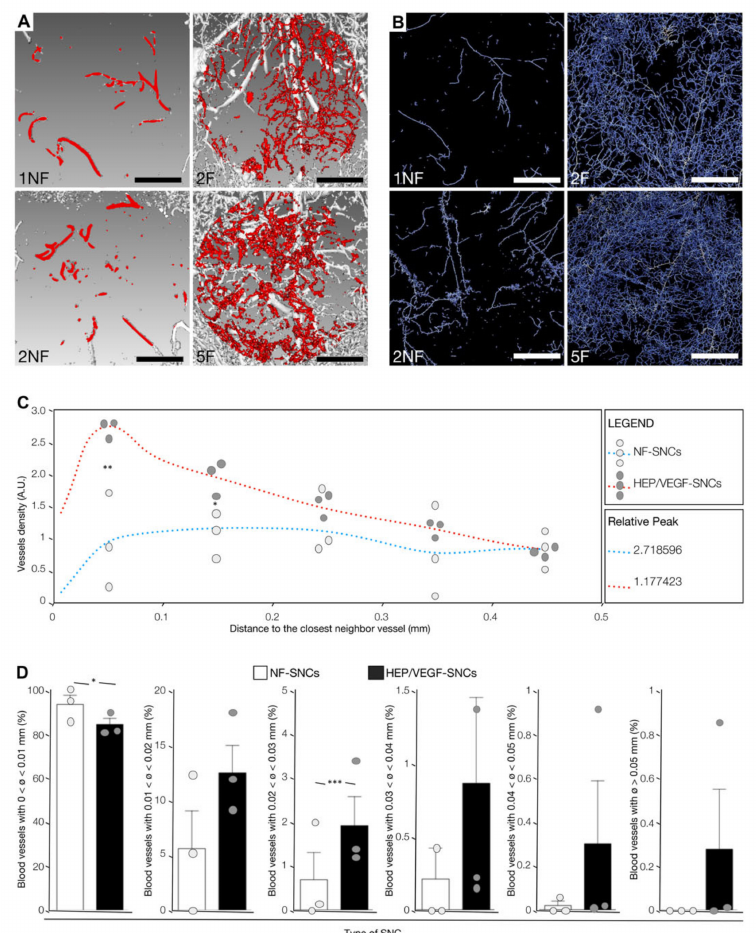
Figure 5. Quantitative analysis of the vasculature found in the bone substitutes implanted in critical- sized calvarial bone defects. ( A ) Micro-CT scans of four representative bone substitutes, deposited with empty (1NF, 2NF) or pro-angiogenic HEP/VEGF (2F, 5F) smart nano-active complexes (SNCs), 12 days after implant. Vessels within the bone substitutes are shown in red. Scale bars: 1 mm. ( B ) Skeletons of the segmented CT images of the vascular networks found in 4 representative bone substitutes, either deposited with NF-SNCs (1NF, 2NF) or with HEP/VEGF-SNCs (2F, 5F). Lighter colors display vessels of larger size. Scale bars: 1 mm. ( C ) Relative density of the vascular networks in 6 bone substitutes, either deposited with NF-SNCs (light grey dots) or with HEP/VEGF-SNCs (dark grey dots), represented in function of the average distance to the closest neighbor vessel. The red and blue dotted lines represent the mean values for HEP/VEGF-SNC and NF-SNC deposited bone substitutes, respectively. *: p < 0.1; **: p < 0.05. ( D ) Hybrid bar/dot plot charts of the relative number of vessels in NF-SNC or HEP/VEGF-SNC deposited bone substitutes, as a function of the blood vessel diameter, 12 days after implant. *: p < 0.1; ***: p < 0.01. Bars represent Mean ± SD ( n =